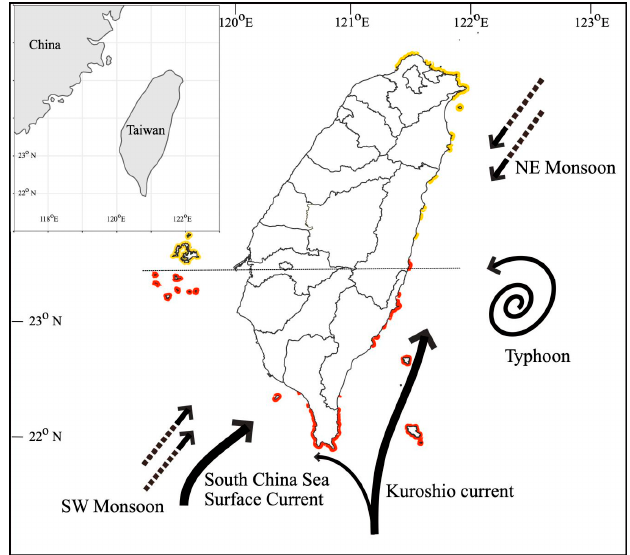
Figure 1. The distribution of corals in Taiwan, including non-reefal communities (yellow) and tropical coral reefs (red) divided roughly by the Tropic of Cancer, and the main climate factors, including the Kuroshio Current, typhoons, and northeast and southwest monsoons. The two types of coral communities are divided by the Tropic of Cancer. The information in the map was adapted from (Dai, C.-F. 2018). Taiwan map was downloaded from free to use Taiwan Map Store (https://whgis.nlsc.gov.tw/English/0-1Introduction.aspx).